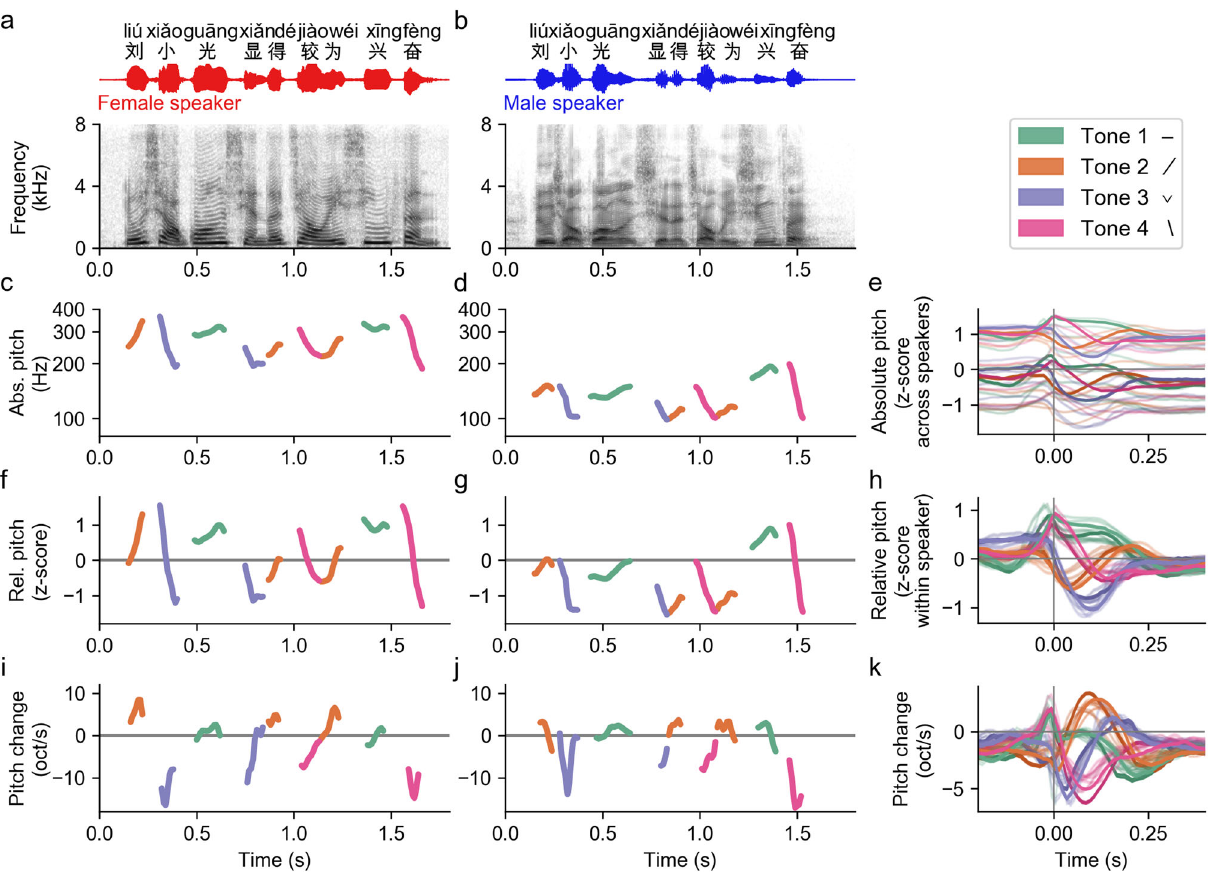
Fig. 1 Speaker-normalized relative pitch and pitch change are key acoustic features for lexical tones in continuous Mandarin speech. a , b Acoustic waveform (top) and spectrogram (bottom) for two example sentences (transcript in Chinese and Pinyin) spoken by a female and a male speaker, respectively. c , d The absolute pitch of the two example sentences. Each syllable is colored according to its lexical tone. e Average absolute pitch contours for each lexical tone aligned to vowel onset for the ten speakers in the speech corpus ( fi ve females, fi ve males). The two speakers of the example sentences are shown in thicker lines. The lighter colored traces are from the female speaker and the darker colored traces are from the male speaker. The absolute pitch contours from the other speakers are shown more transparently. f , g The relative pitch contours of the example sentences, colored by the lexical tone of each syllable. Relative pitch is calculated by normalizing pitch values by speaker ( z score of log Hz). h Average relative pitch for each tone aligned to vowel onset for all ten speakers. i , j Pitch change of the example sentences, colored by the lexical tone of each syllable. k Average pitch change for each tone aligned to vowel onset for all ten